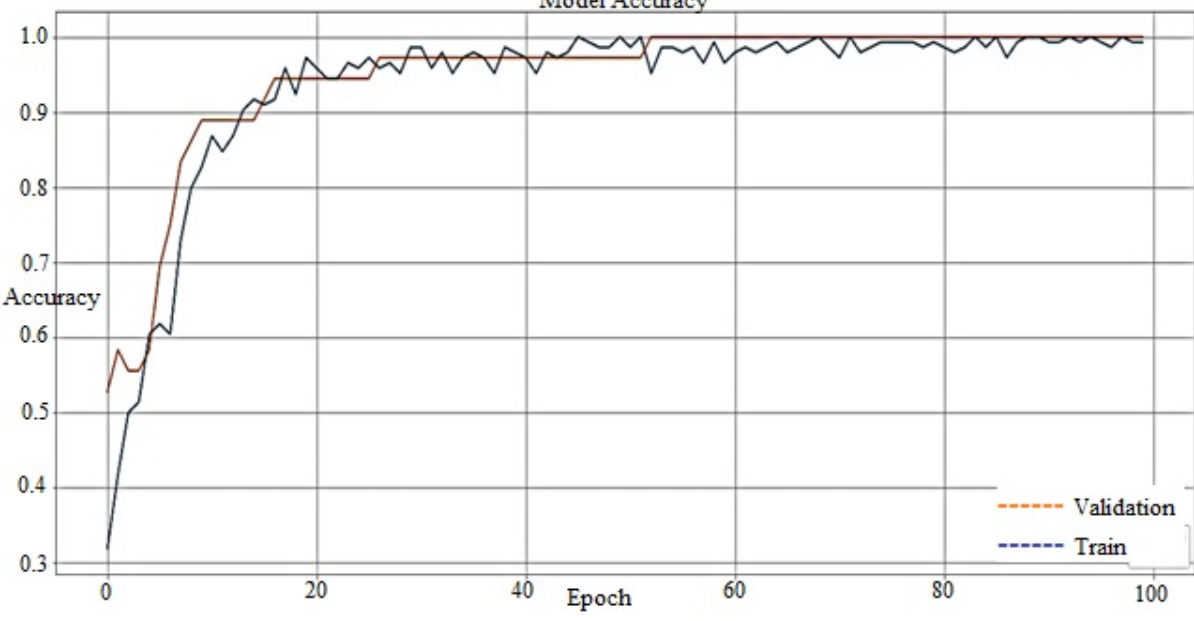
Figure 13. Accuracy curve of the model.